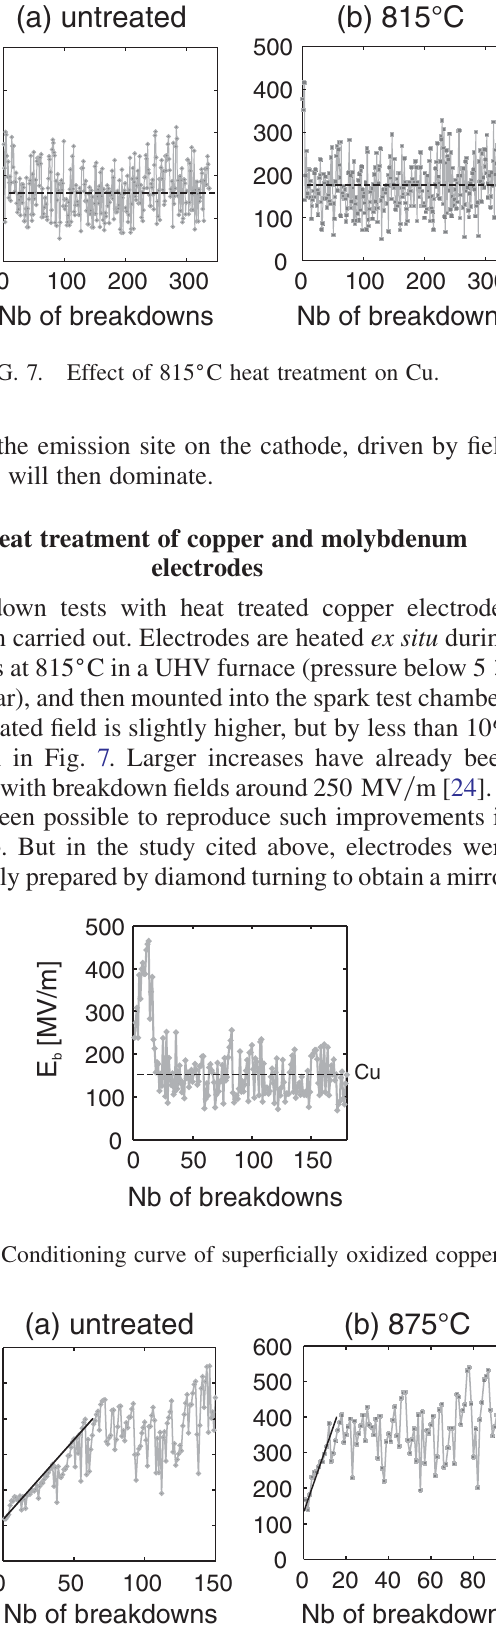
FIG. 9. Improvement in conditioning speed of Mo due to heat treatments.